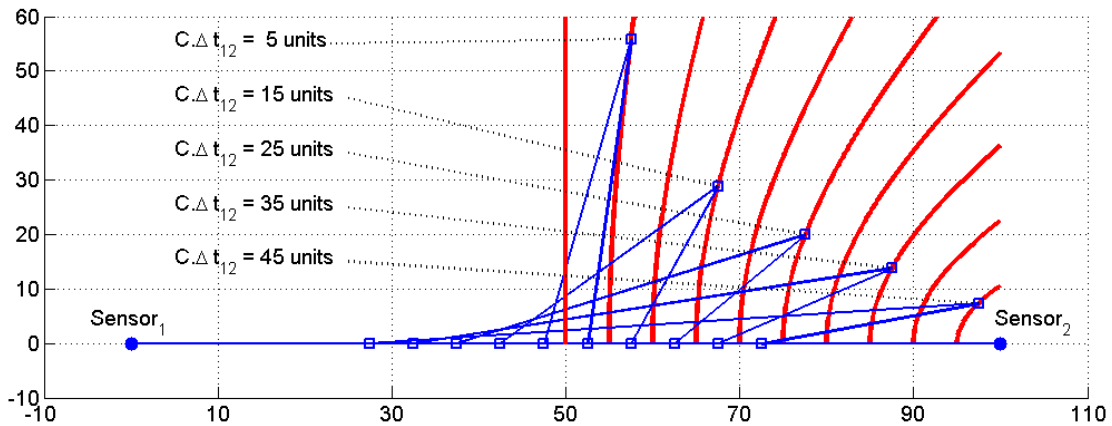
Figure 2. Family of hyperbolas branches for a given pair of sensors.